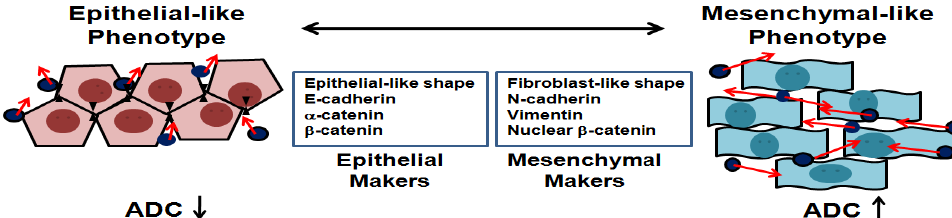
Figure 6. Epithelial-mesenchymal transition (EMT) is an evolutionarily conserved morphogenic process in which epithelial cells lose their epithelial characteristics and become invasive. EMT and the reverse process, mesenchymal-epithelial transition are increasingly recognized as the mechanistic basis for metastatic dissemination of epithelial tumors. Water molecules ( full circles ) and Brownian motion ( arrows ) at extracellular spaces contribute to the DW-MRI signal. Epithelial-like cells showed low ADC values, indicating that water molecules move with restriction in extracellular space. Mesenchymal-like cells with spindle-shape morphology showed higher ADC values, indicating increasing extracellular water